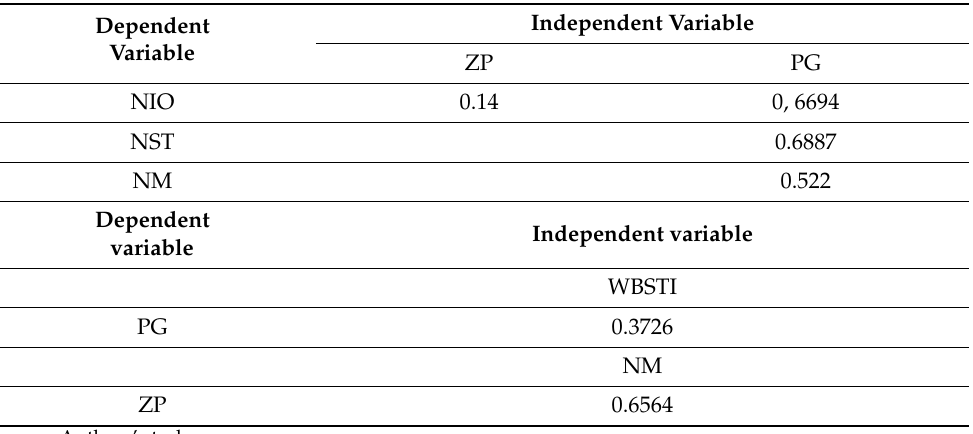
Table 5. The asymptotic p values for the residuals of the cointegration